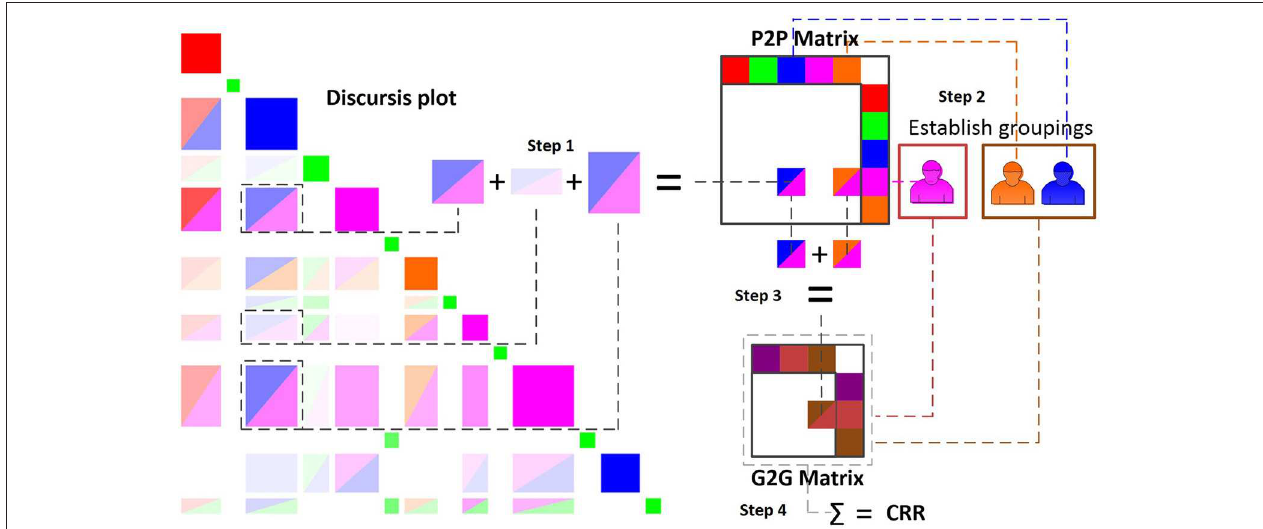
FIGURE 4 | CRQA pyramid measures. This diagram [reproduced from Angus and Wiles [20] with permission] shows how recurrence can be aggregated over different levels, from individual interlocutors to social groups.